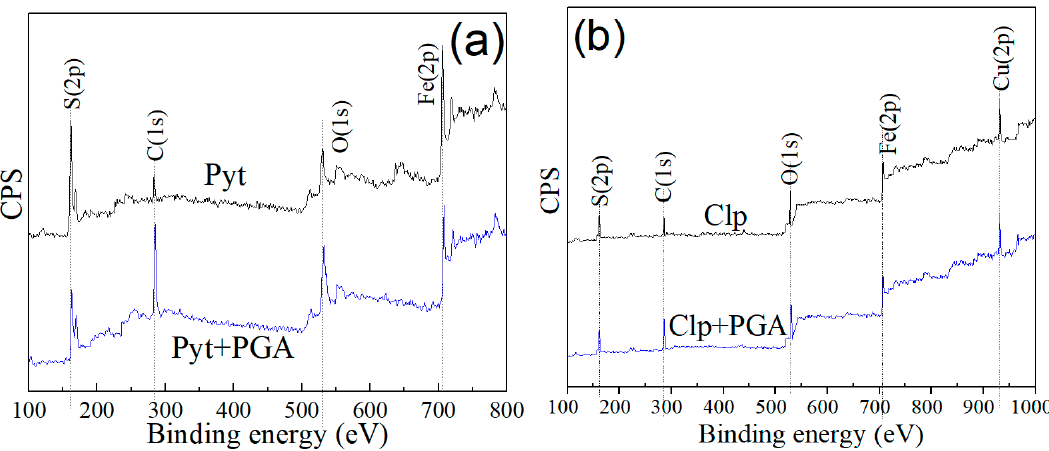
Figure 9. XPS spectral results of ( a ) pyrrhotite (Pyt) and ( b ) chalcopyrite (Clp) before and after the reaction with 50 mg/L PGA at pH 8. Table 3. Elemental concentration of important species in the absence and presence of 50 mg/L PGA at pH 8.